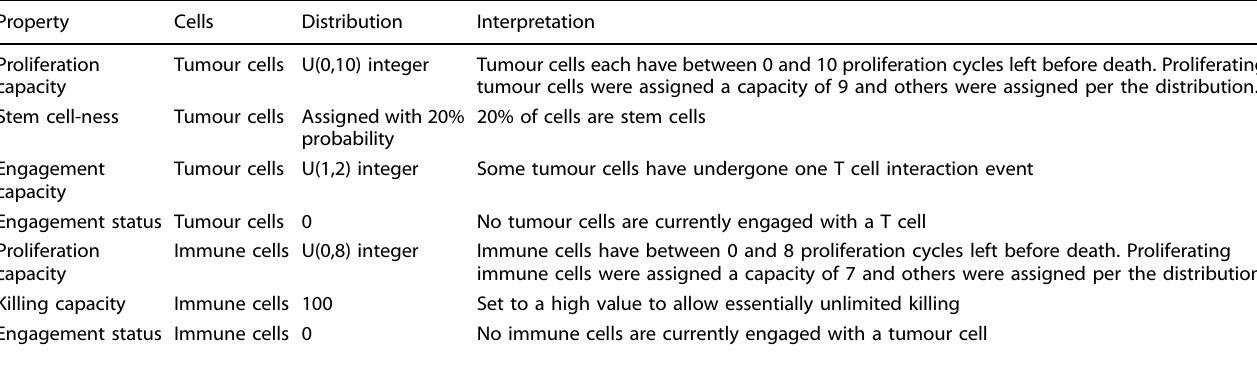
Table 3. Assigned properties of the tumour cells and immune cells in the preprocessing script.